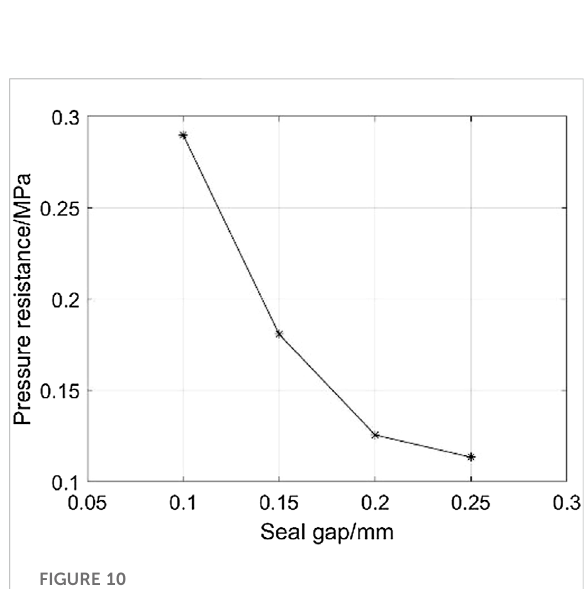
Relationship between seal gap size and pressure